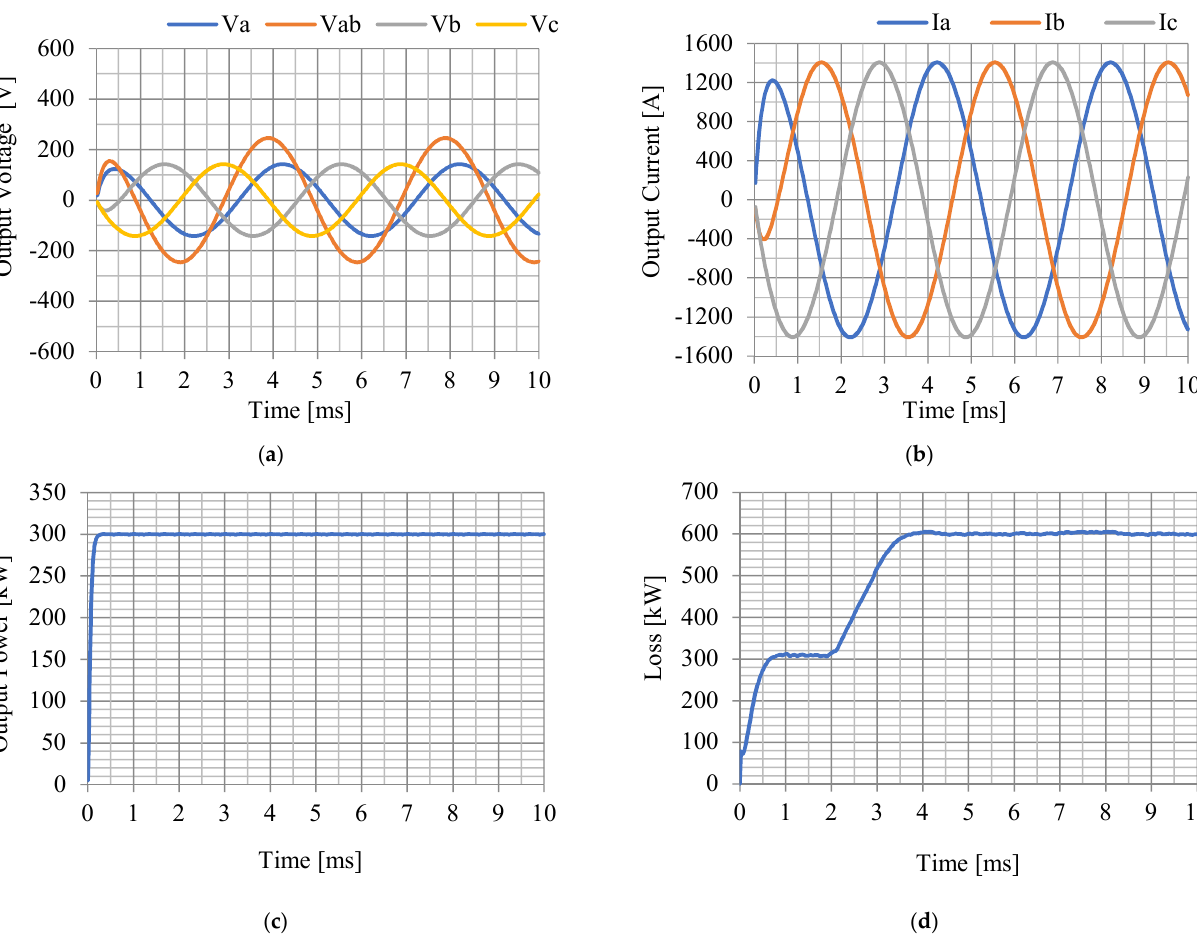
Figure 14. Characteristics at 15 krpm (300 kW power generation state): ( a ) Output voltage. ( b ) Output current. ( c ) Output power. ( d ) Loss.